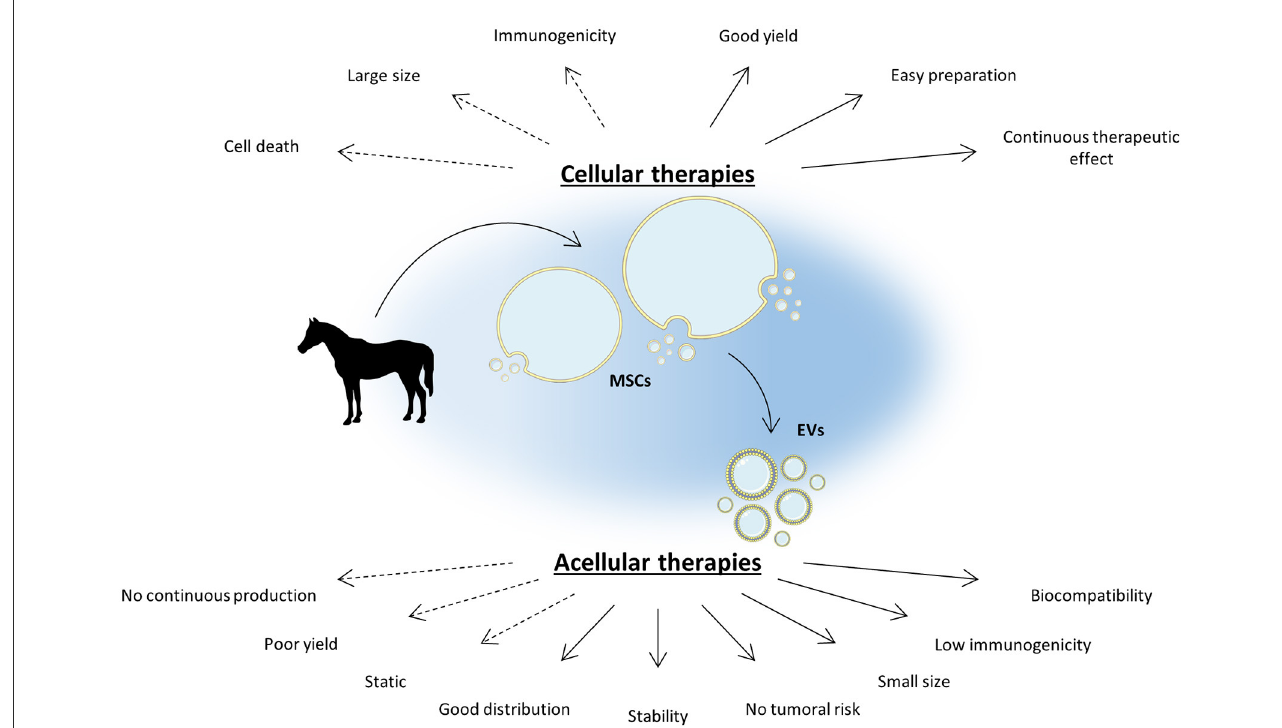
FIGURE1 MSC-based acellular therapies are an appealing strategy to bypass cellular therapy limitations. Cellular therapies based on mesenchymal stromal cells (MSCs) demonstrate a promising potential in the management of equine osteoarthritis (OA) by reducing joint inflammation and enhancing cartilage regeneration. However, MSC intra-articular injection can be immunogenic and brings several concerns inherent to their nature. As the main part of MSC therapeutic potential lies in their secretome, notably in extracellular vesicles (EVs), acellular therapies appear to be a promising alternative to increase the safety of MSC-based therapy while improving its efficacy. EVs are highly biocompatible and can easily diffuse into tissues thanks to their small size. To date, acellular therapies still exhibit a few limitations but several strategies are in progress to overcome them. The Figure was partly generated using Servier Medical Art, provided by Servier, licensed under a Creative Commons Attribution 3.0 unported